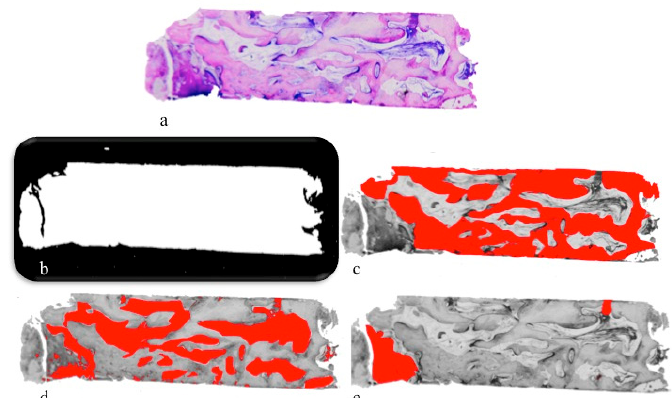
Figure 4. The sections of the harvested biopsies ( a ), analyzed for: Mean surface of the specimen ( b ); newly formed bone area ( c ); connective tissue area ( d ); residual graft particles area ( e ).